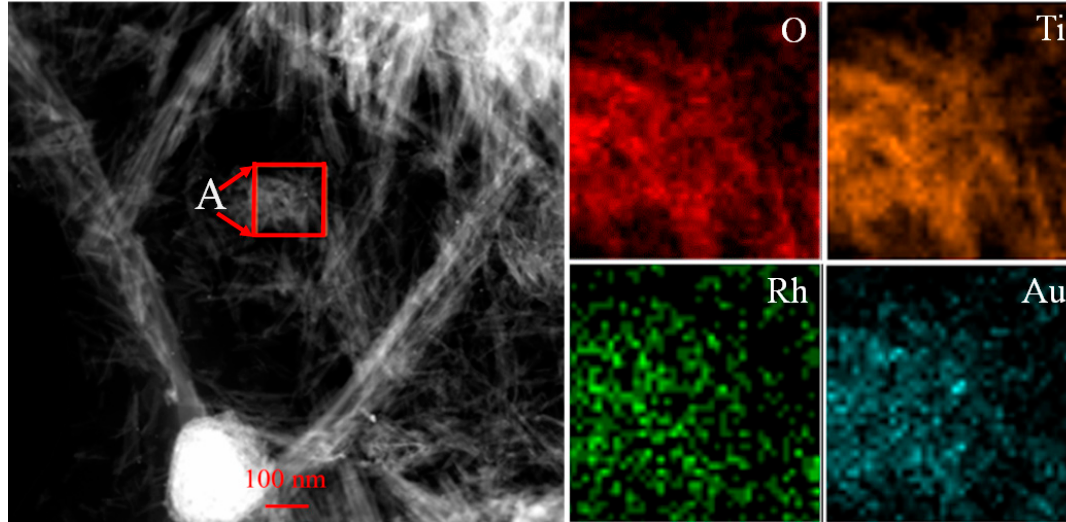
Figure 1. HAADF ‐ STEM image ofAu 0.52 /Rh 0.32 /TNTs ‐ 12 (A) and EDX mapping of O, Rh Ti andAu in Figure 1. HAADF-STEM image ofAu 0.52 /Rh 0.32 /TNTs-12 (A) and EDX mapping of O, Rh Ti andAu in the marked area of A. the marked area of